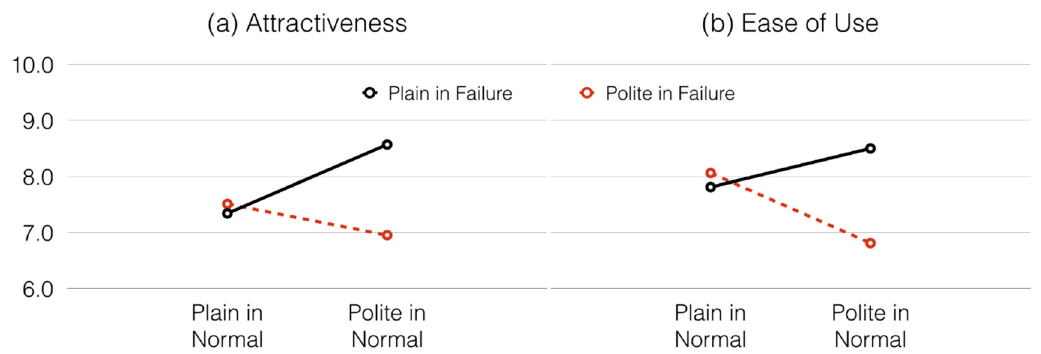
Figure 4. Interaction Effects between Politeness Strategies in Different Situations on Experience Components, ( a ) attractiveness and ( b ) ease of